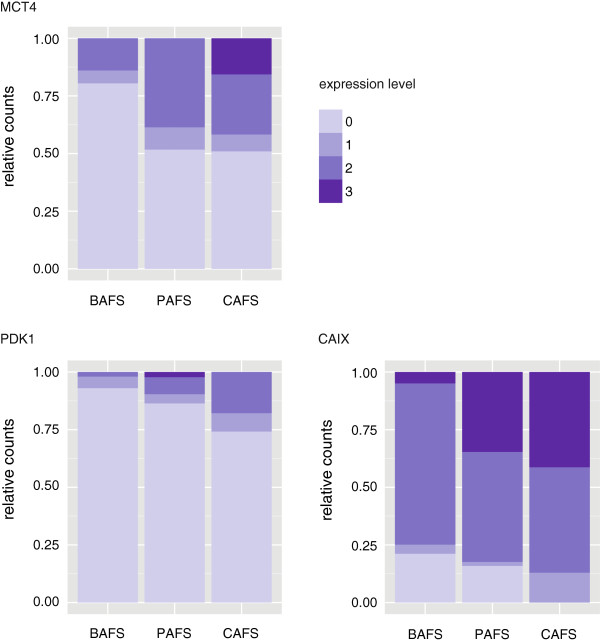
Stacked bar graph according to one protein column within each fibroblast group for MCT4, PDK1 and CAIX expression. The stronger expression (3) is represented by the more intense colour.